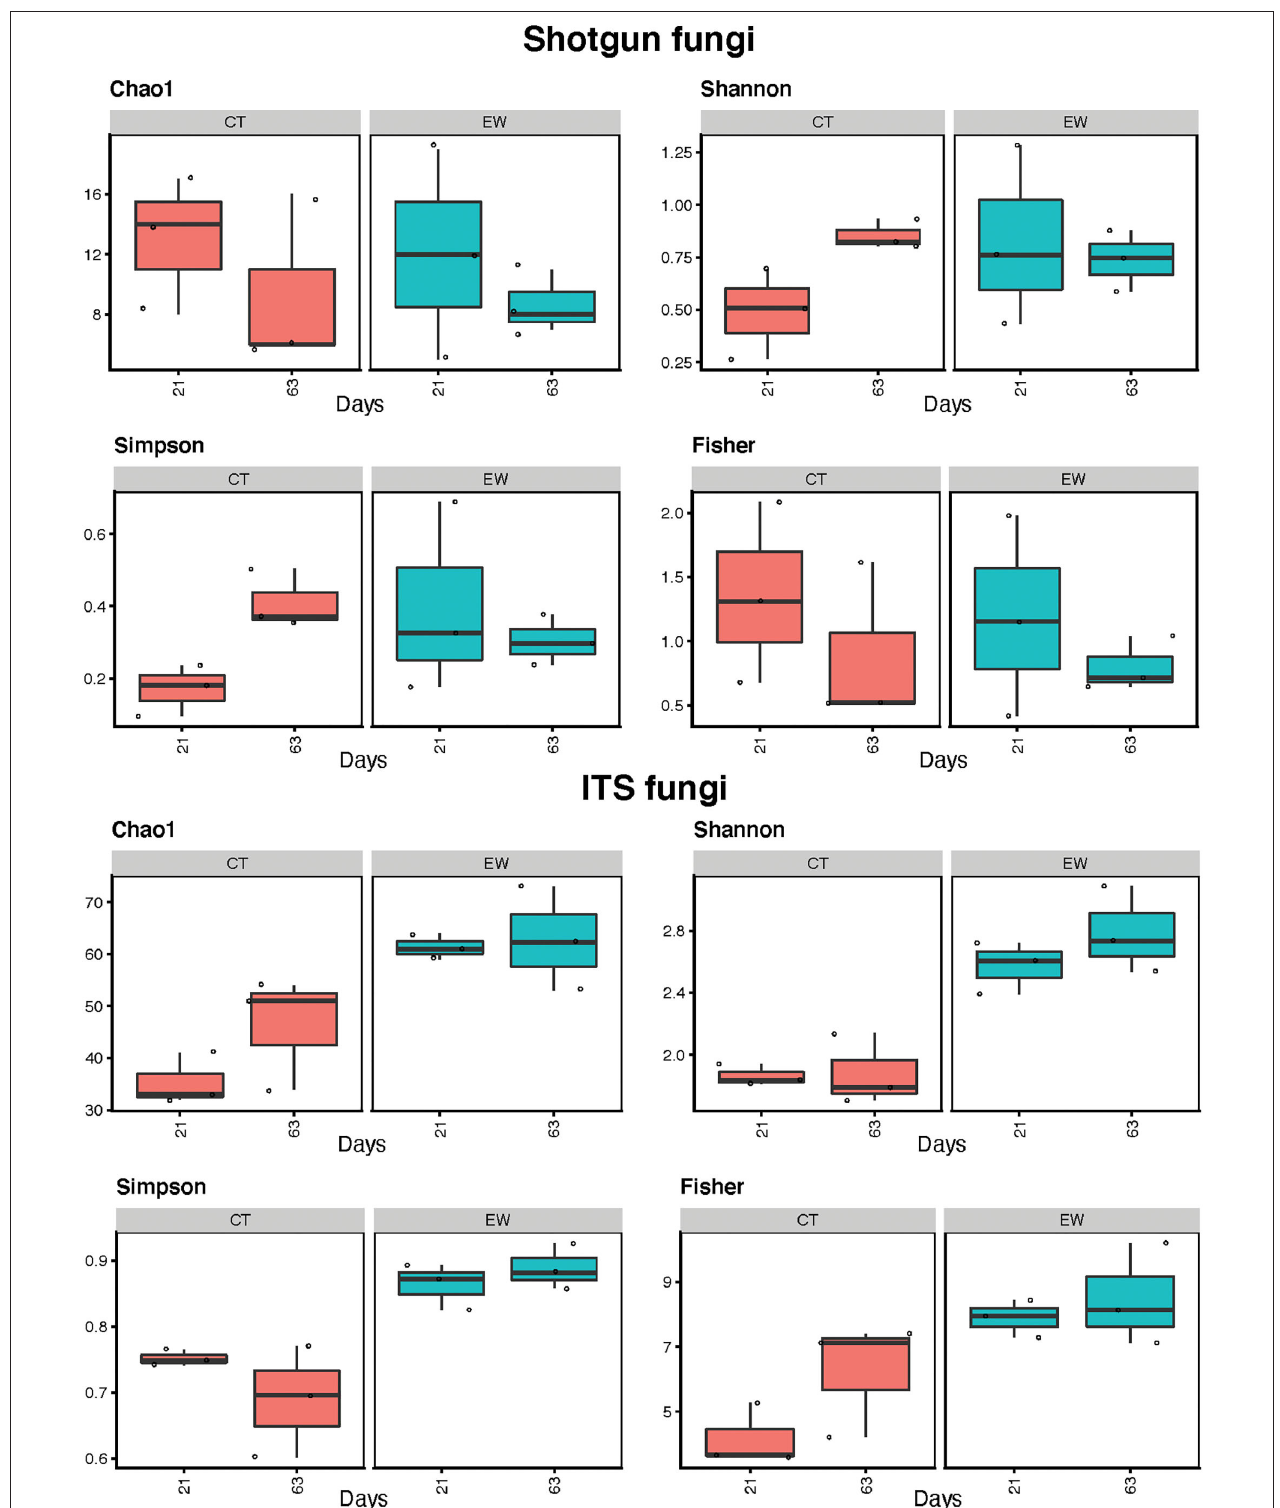
FIGURE 6 | Fungal alpha-diversity estimates (Chao1, Shannon, Simpson, and Fisher indices) for treatment (control, CT; earthworm, EW) and age (21 and 63 days) groups for shotgun metagenomic and ITS metataxonomic strategies.